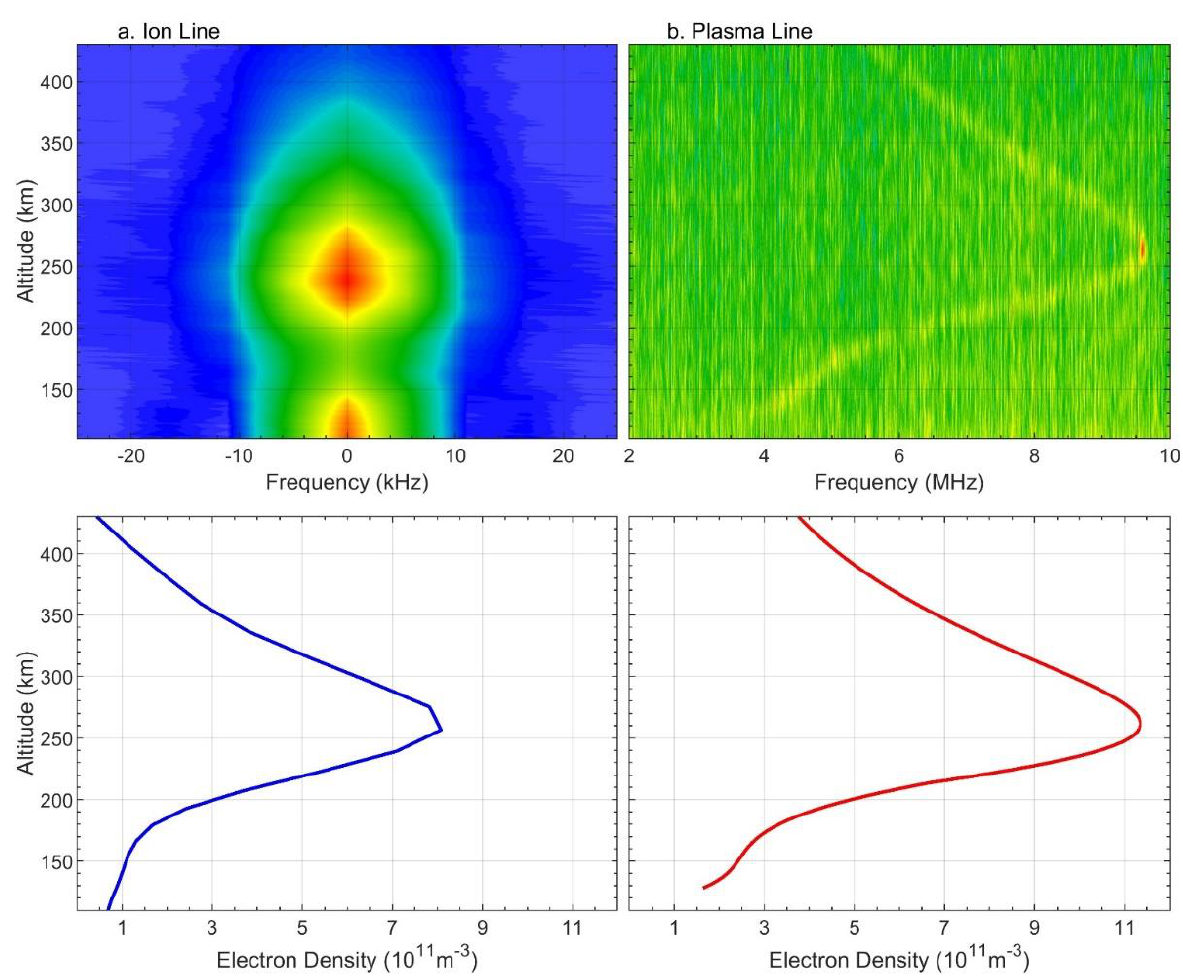
Figure 1. An example of simultaneously measured ion line ( a ) spectra and plasma line ( b ) spectra (top row) and the corresponding derived electron density profiles (bottom row). The experiment was produced by SYISR at 28 December 2021 10:14:17 local time.